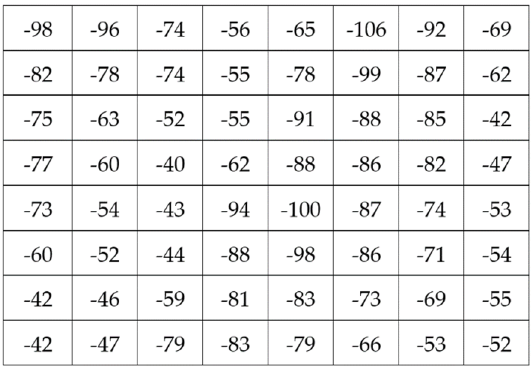
Figure 5. Pixels values in range [ − 128, 127].